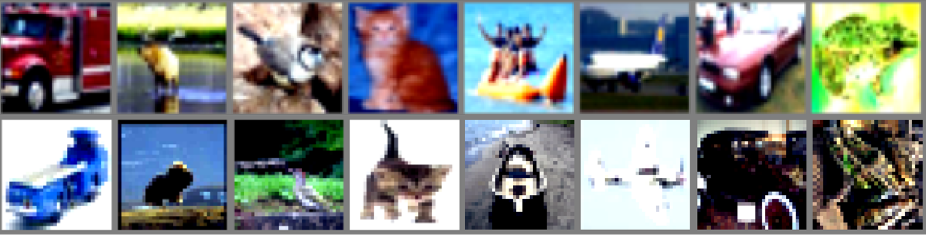
Figure 6. The typical images from the CINIC-10 dataset. Top: inherited from the CIFAR-10 dataset. Top: extended from the ImageNet dataset. The labels from left to right: truck, deer, bird, cat, ship, plane, car, and frog.